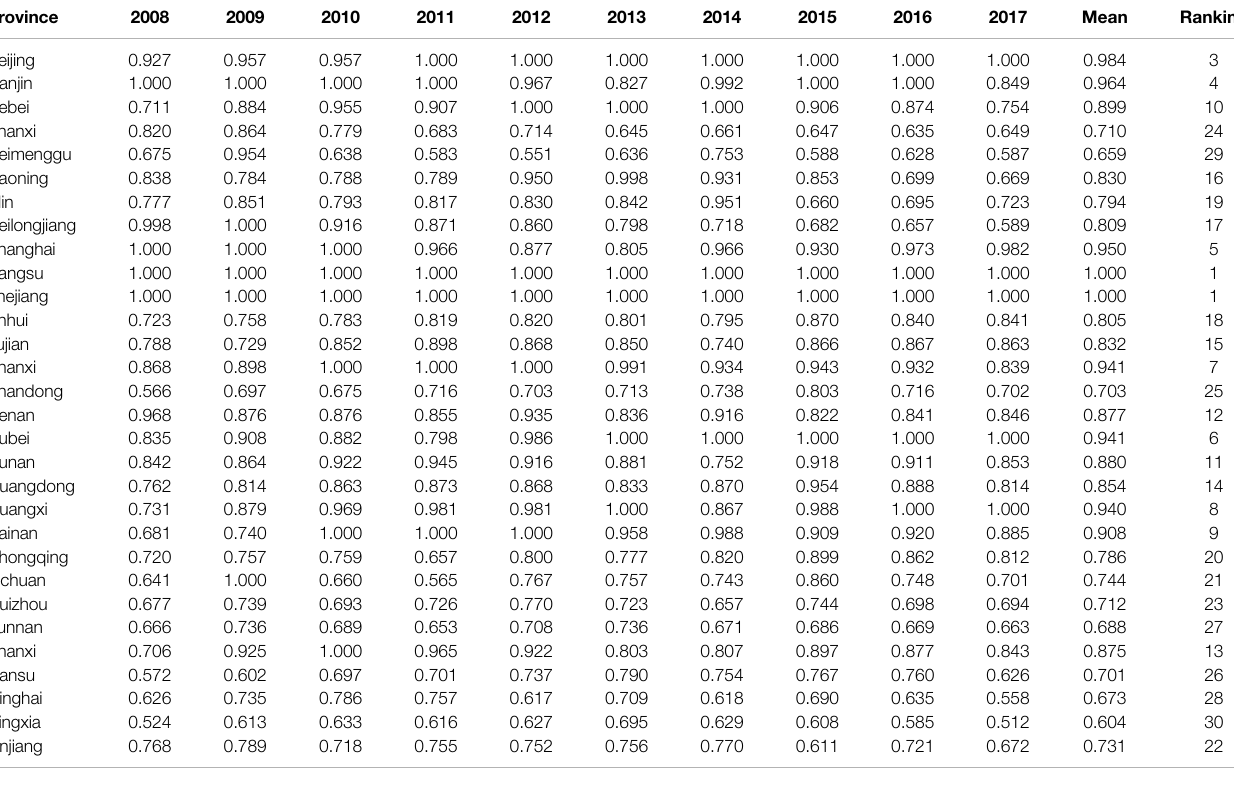
TABLE 1 | Energy ef fi ciency of China ’ s provincial construction industry from 2008 to 2017. Province Ranking